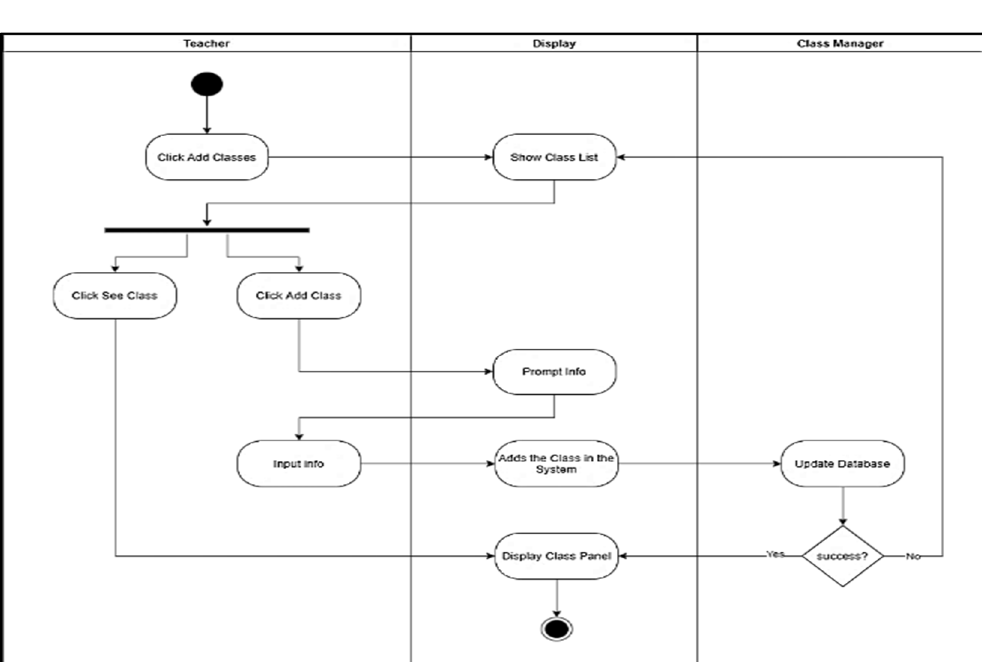
Figure 2. Use Case Diagram.